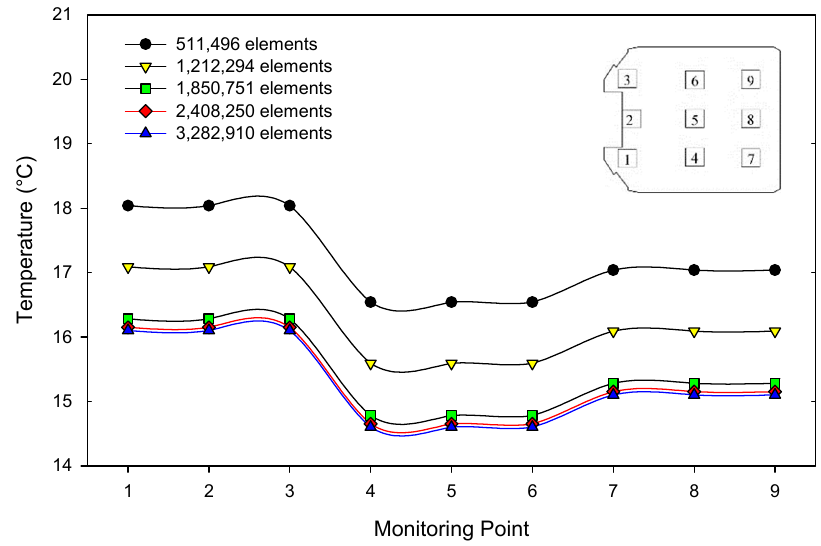
Figure 2. Grid independence test at supply air temperature 13 °C and air velocity 2 m/s.